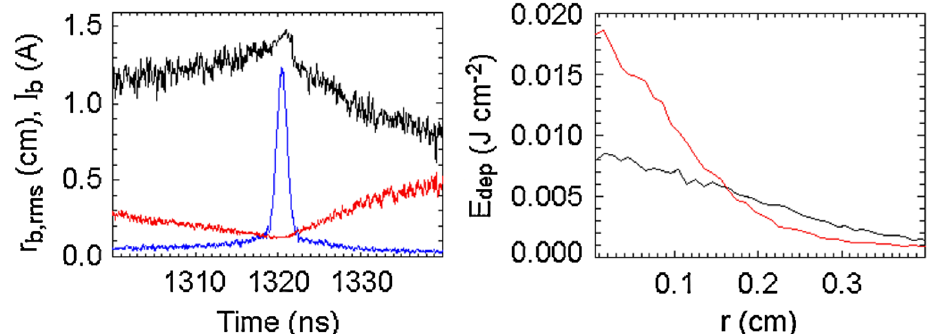
ADVANCED PLASMA FLOW SIMULATIONS . .